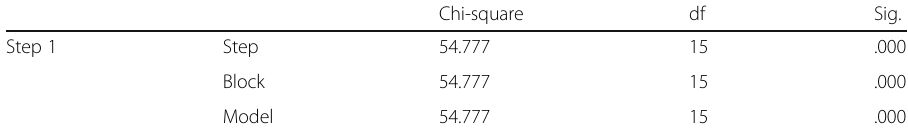
Table 18 Omnibus tests of model coefficients